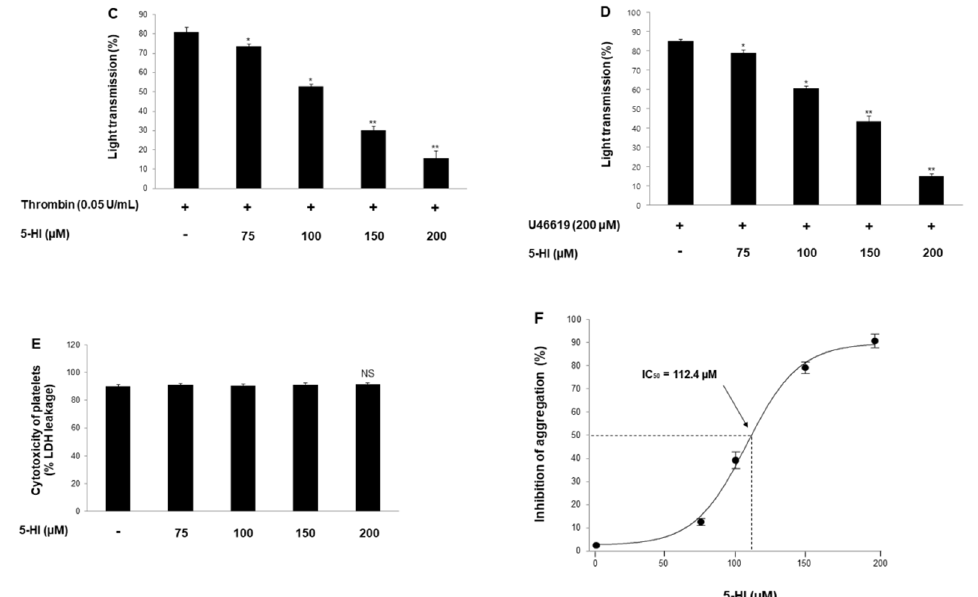
Figure 1. Effect of 5-HI on platelet aggregation. ( A ) Chemical structure of 5-HI (5-hydroxyindolin-2-one, MW. 149.15). ( B ) 5-HI’s effect on collagen-induced human platelet aggregation. ( C ) 5-HI’s effect on thrombin-induced human platelet aggregation. ( D ) 5-HI’s effect on U46619-induced human platelet aggregation. ( E ) 5-HI’s effect on cytotoxicity. ( F ) Half maximal inhibitory concentration (IC 50 ) value of 5-HI in collagen-induced human platelet aggregation. Platelet aggregation and cytotoxicity were carried out as described in “Materials and Methods” section. The data are expressed as the mean ± standard deviation (n = 4). * p < 0.05, ** p < 0.01 versus each agonist-stimulated human platelets. NS—not significant.